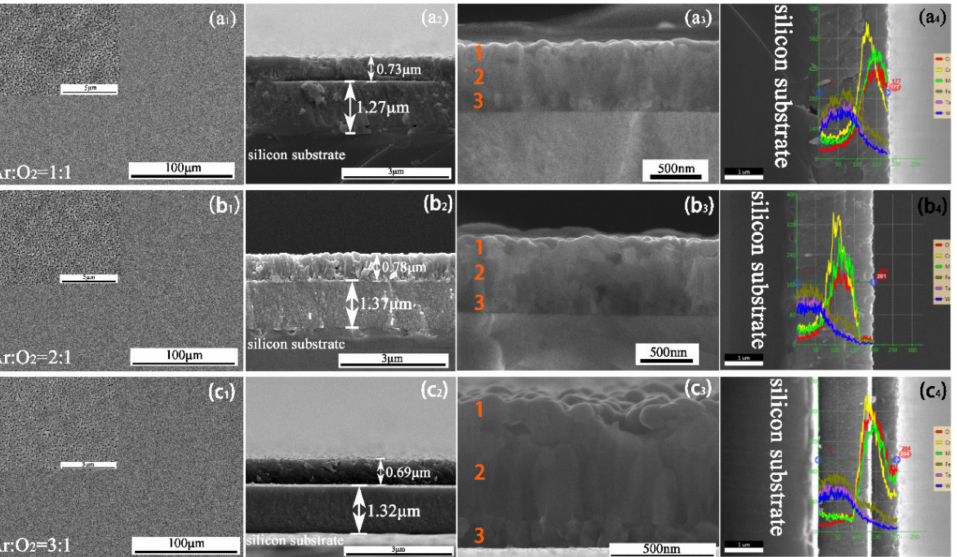
Figure 5. The morphology and element distribution of S 1 , HT2 and HT3: ( a 1 – c 1 ) SEM surface images; ( a 2 , a 3 ), ( b 2 , b 3 ), ( c 2 , c 3 ) Cross-section images; ( a 4 – c 4 ) EDS line scan